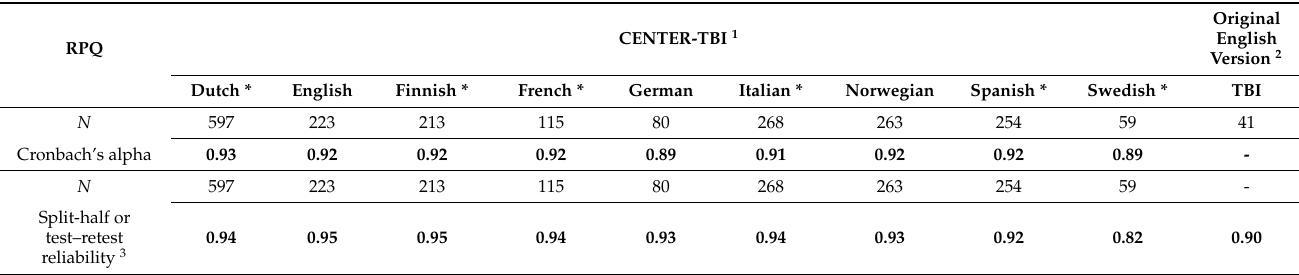
Table 4. Reliability of the RPQ: Comparison of the CENTER-TBI results with the values from the original English validation study in the field of